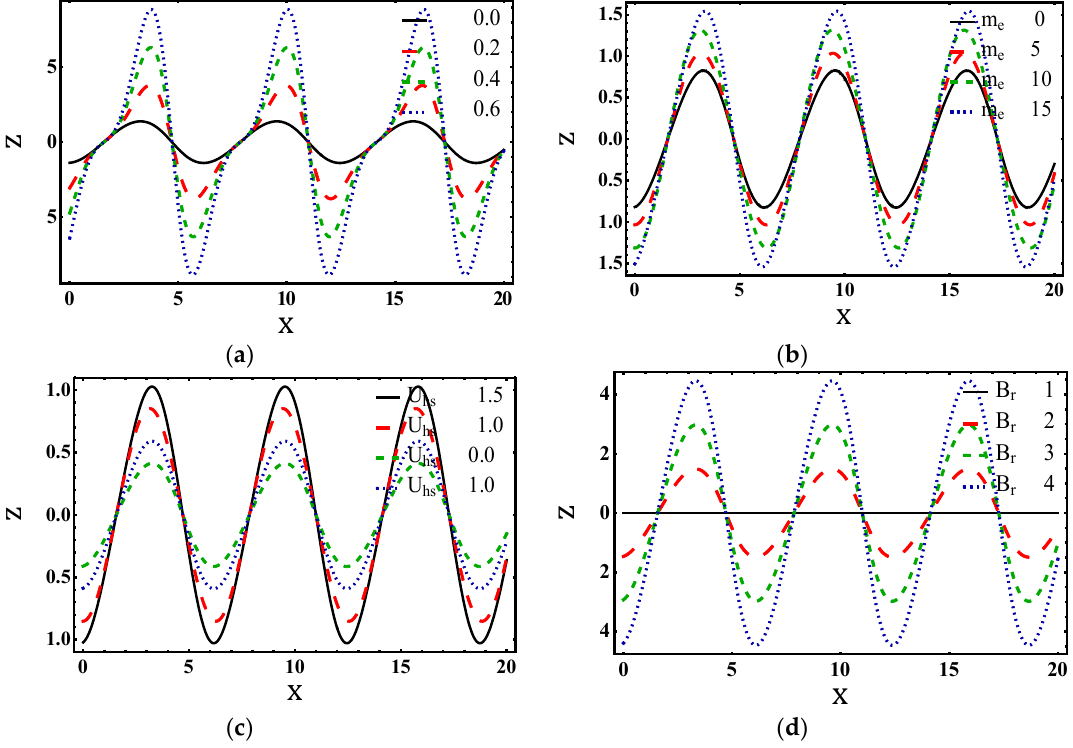
Figure 11. Heat transfer coe ffi cient for ( a ) . Г ( b ) . m e ( c ) . U hs ( d ) . B r , while other parameters are Г = 0.01, ε = 0.2, Θ = 1.2, m e = 10, U hs